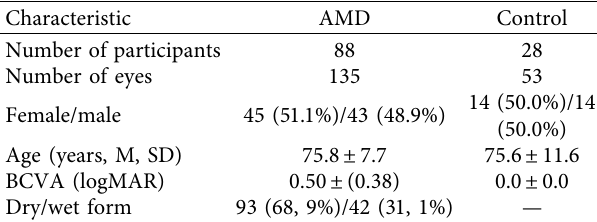
Table 1: Demographic data of participants.